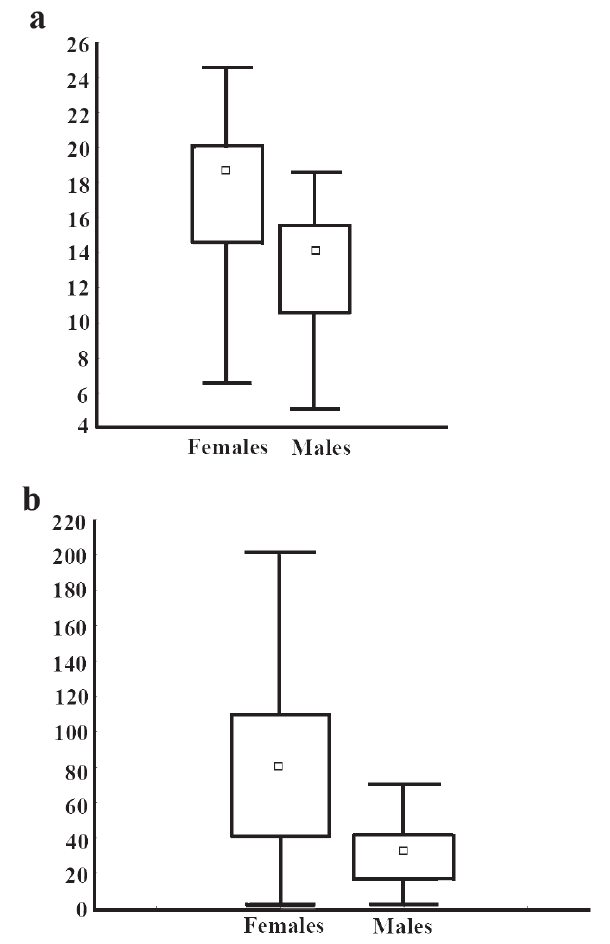
Fig. 3. Between-sexes variation in ( a ) standard length and ( b ) weight in Anableps anableps from the Maracanã River, Pará State.